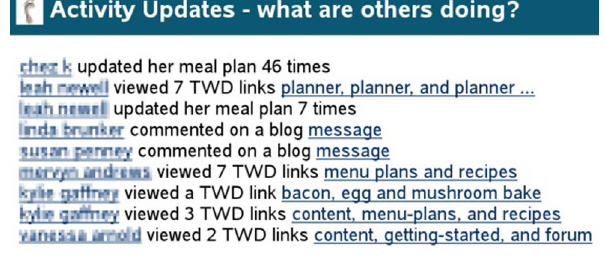
FigUre 2 | social network activity feed